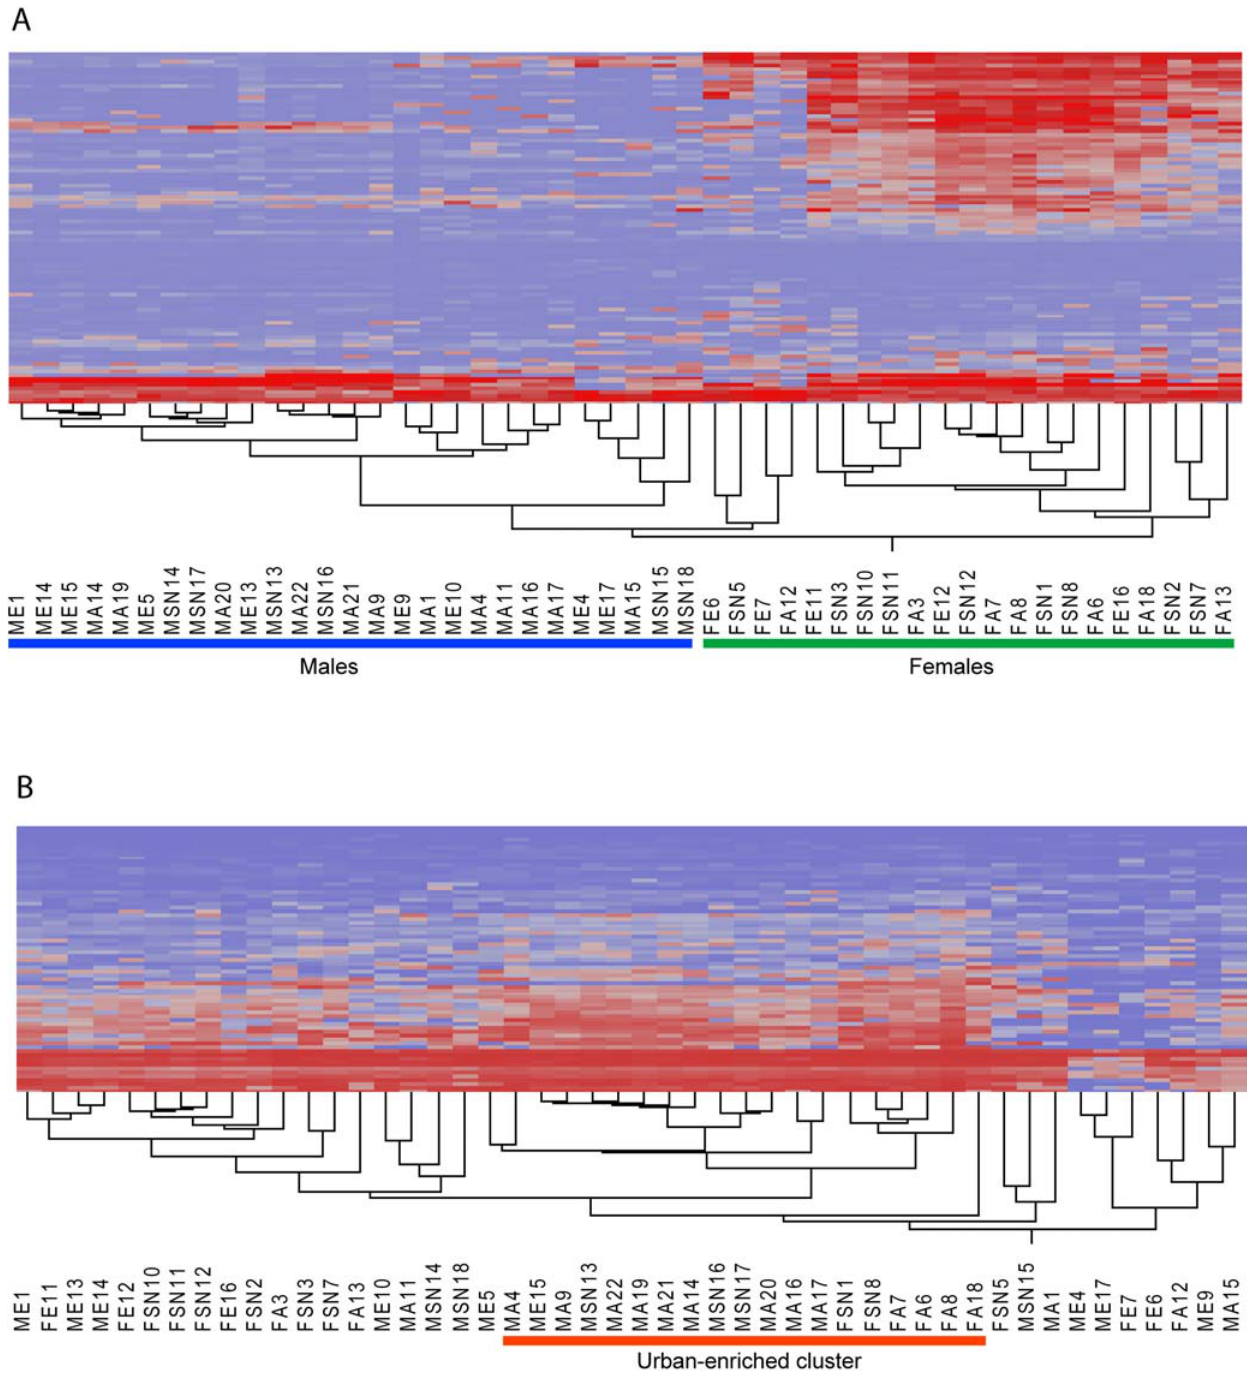
Figure 3. Sex and location effects on methylation patterns. Two-way clustering of differentially methylated CpG sites at P , 0.05 (ANOVA) for the sex effect (A) and for the location effect (B). Sample labels indicate their sex and location (M: male, F: female, E: nomad, SN: rural, and A: urban). There is clear separation of the sexes in (A), and a suggestion of a signature of urban living for a dozen or so genes in (B) highlighted as the Anza- enriched cluster.